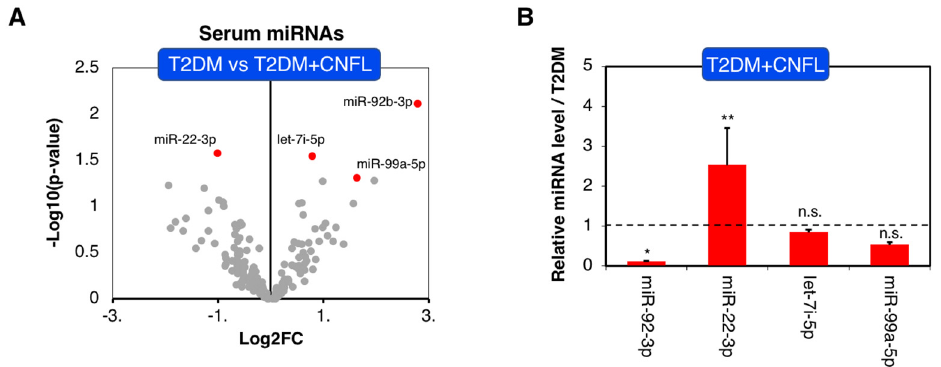
Figure 2. Q-PCR-based serum microRNA expression analysis from T2DM patients with (T2DM) and without significant corneal nerve loss labeled as T2DM and T2DM + CNFL, respectively. ( A ) Volcano plot comparing serum microRNA profiles among T2DM and T2DM + CNFL. The figure illustrates the relationship of FC (log base 2) to the p -value ( − log base 10). The red dots represent differentially expressed microRNAs with a false discovery rate (FDR) < 0.05 and absolute log2 fold change > 0.5. ( B ) Expression level of the four most significantly altered microRNAs in T2DM + CNFL relative to T2DM (dashed line indicates T2DM level); * p < 0.05, ** p <0.01. Error bars represent SEM. n.s. represents non-significant ( p >0.05).